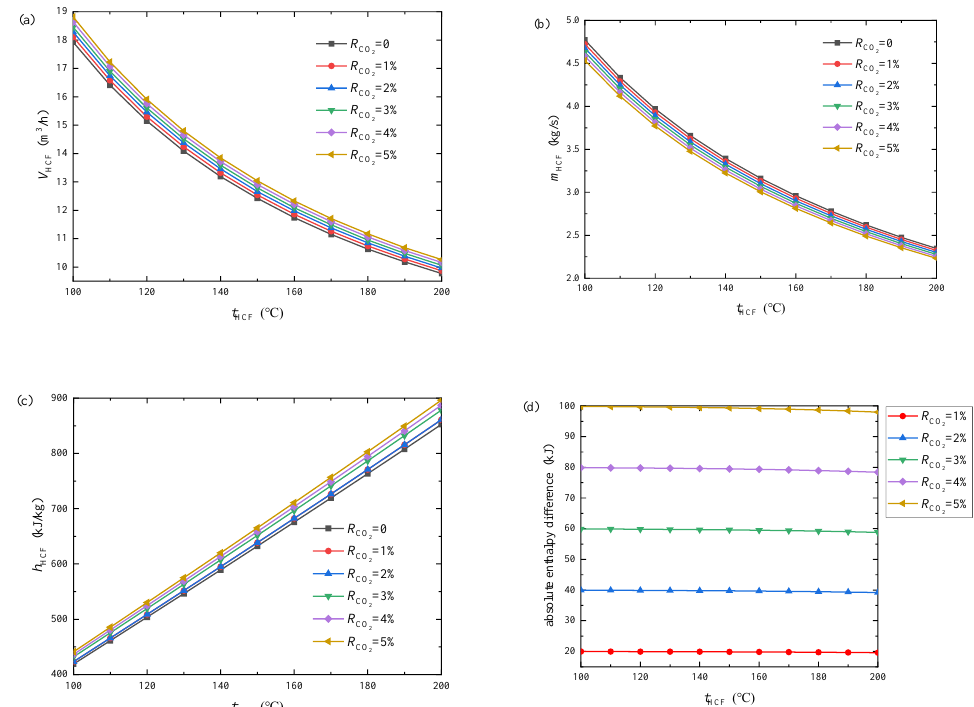
Figure 11. Variation curves of production capacity parameters of heat carrier with t HCF under differ- ent R CO2 : ( a ) volume flow rate, ( b ) mass flow rate, ( c ) enthalpy and ( d ) absolute enthalpy difference.